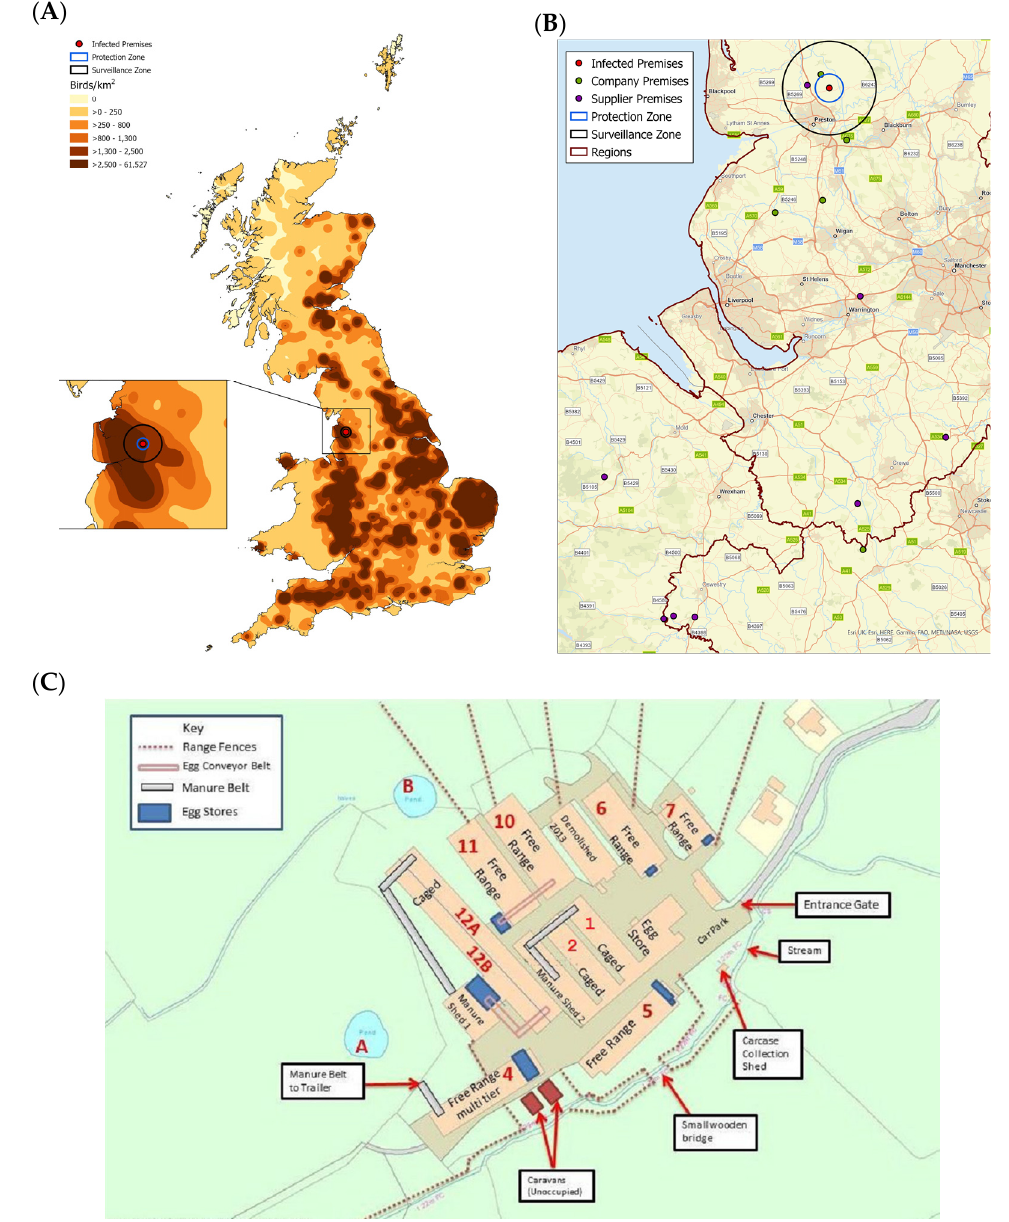
Figure 1. The IP was located in a poultry-dense area in the northwest of England. ( A ) A map showing the density of poultry across Great Britain. The map was created using an extract of the Animal and Plant Health Agency (APHA) animal holding database at the time of the investigation. The density of birds was determined using the kernel density function in ArcGIS using a 15 km search radius and output cell size of 1 km. The location of the IP, 3 km protection zone (PZ) and 10 km surveillance zone (SZ) are also shown. ( B ) A map showing the locations of linked premises, represented by green, company-owned premises, and purple, supplier premises, dots. The location of the IP, 3 km PZ and 10 km SZ and the regions are also shown. ( C ) A diagram depicting the site plan of the IP. The sheds are labelled accordingly with their numbers and the type of housing. The location of range fences, egg conveyor belts, manure belts and eggs stores, as well as ponds are also shown.